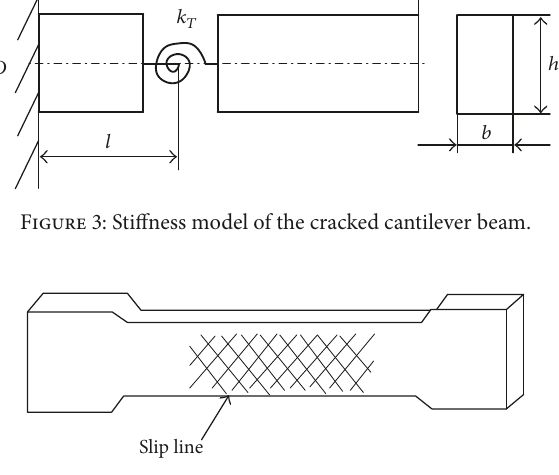
Slip line Figure 4: Yield slip